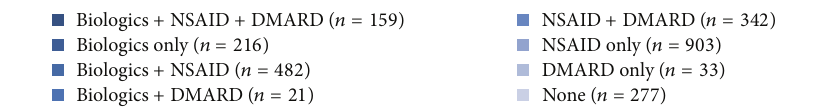
Figure 3: Total annual costs of ankylosing spondylitis prevalent patients by treatment type. Table 3: Marginal effects calculated after generalized linear model